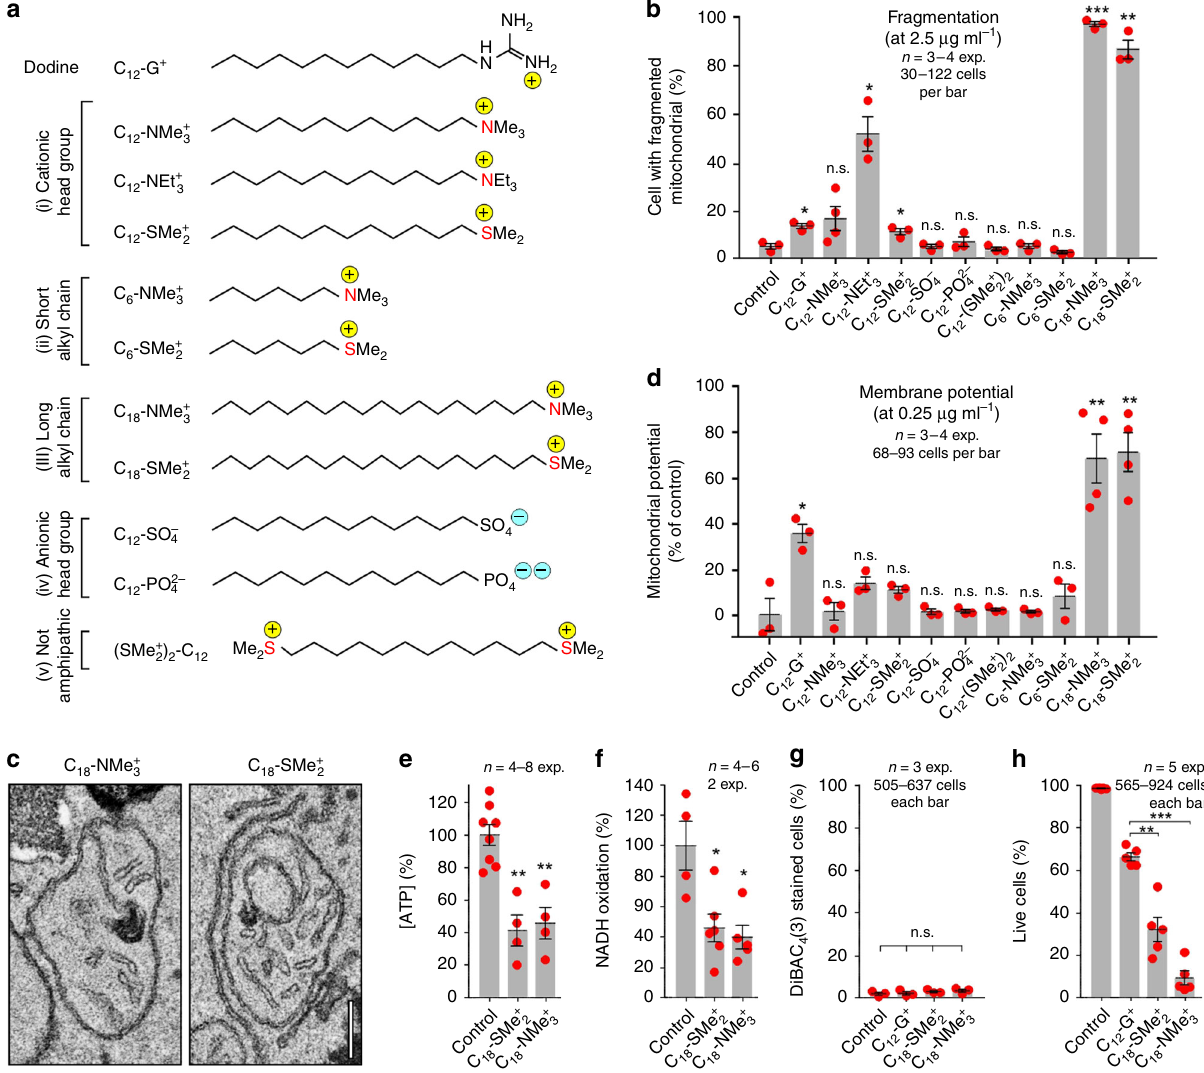
Fig. 4 Effect of various MALCs and related compounds on mitochondria in Z. tritici . a Structure of MALCs and related compounds. Ionic charges are indicated by “ + ” and “ − ” . The counter ions for all lipophilic cations are: (1) acetate (C 12 -G + ), (2) bromide (C 12 -NMe 3 + , C 12 -NEt 2 + , C 6 -NMe 3 + , C 18 - NMe 3 + ), (3) iodide (C 12 -SMe 2 + , C 6 -SMe 2 + , C 18 -SMe 2 + , (SMe 2 + ) 2 -C 12 ). b Effect of MALCs and related compounds on mitochondrial fragmentation in Z. tritici at 2.5 µ g ml − 1 . See also Supplementary Figs. 4a, 5. c Effect of various C 18 -NMe 3 + and C 18 -SMe 2 + on mitochondrial ultrastructure of mitochondria. Note swollen cristae. Scale bar = 0.2 µ m. d Effect of various compounds on mitochondrial inner membrane potential, monitored using TMRM, in Z. tritici at a concentration of 0.25 µ g ml − 1 . e Bar chart showing the relative amount of ATP in cell extracts, pre-treated for 2 h with C 18 -SMe 2 + and C 18 -NMe 3 + . The ATP concentration in cell extracts from solvent-only treated cells was set to 100%. ATP concentration was measured using a luciferase-based assay. f NADH oxidation measured in isolated mitochondria in the presence of C 18 -SMe 2 + and C 18 -NMe 3 + . g Number of DiBAC 4 (3)-positive cells ( = depolarized cells), treated with solvent (Control), C 18 -SMe 2 + , C 18 -NMe 3 + and C 12 -G + . Only cells that were negative for live/dead staining were included in the analysis. h Quantitative live/dead staining of cells after treatment with C 12 -G + , C 18 -SMe 2 + , and C 18 -NMe 3 + . Values ( b , d – h ) are shown as mean ± SEM. Red dots represent data points. Sample size n is indicated in each panel. Student ’ s t -testing with Welch correction in ( b , d – h ) and one-way ANOVA ( g ); n.s. non-signi fi cant difference to control ( P > 0.05; b , d , g ); * P = 0.0127 ( b , C 12 -G + ), 0.0236 ( b , C 12 -NEt 3 + ), 0.0391 ( b , C 12 -SMe 2 + ), 0.0226 ( d ), 0.0428 ( f , C 18 -SMe 2 + ), 0.0281 ( f , C 18 -NMe 3 + ); ** P = 0.0024 ( b ), 0.0061 ( d , C 18 -NMe 3 + ), 0.0031 ( d , C 18 -SMe 2 + ), 0.0037 ( e , C 18 -SMe 2 + ), 0.0055 ( e , C 18 - NMe 3 + ), and 0.0048 ( h ); *** P < 0.0001 ( b , h ). All P -values are two-tailed. See Supplementary Table 7 for experimental conditions. All source data are provided as a Source Data fi